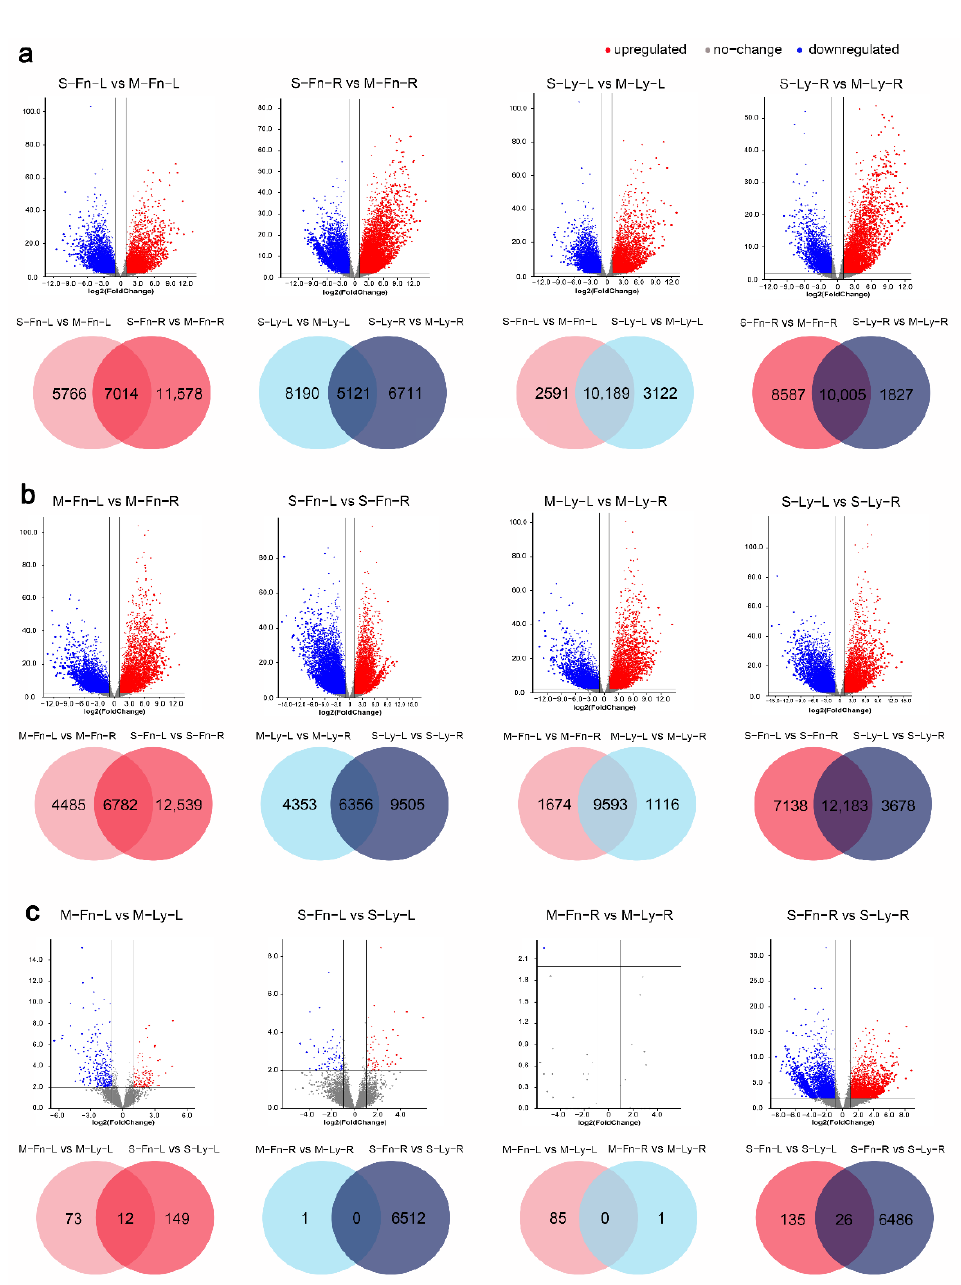
Figure 4. Differentially expressed genes (DEGs) were induced by ( a ) saline stress, ( b ) different organs, or ( c ) different genotype in Fanni and Longya10. The upregulated DEGs were marked with red spots, and the downregulated DEGs were marked with blue spots on the volcano map, respec- tively. Common and unique DEGs were calculated by Venn analysis. M −Fn−R and M −Ly−R repre- sent the root samples derived from Fanni and Longya10 plants, respectively. S −Fn−R and S −Ly−R represent the saline-stress-treated root samples derived from Fanni and Longya10 plants, respec- tively. M−Fn−L and M−Ly−L represent the leaf samples derived from Fanni and Longya10 plants, respectively. S−Fn−L and S−Ly−L represent the saline -stress-treated leaf samples derived from Fanni and Longya10 plants, respectively.